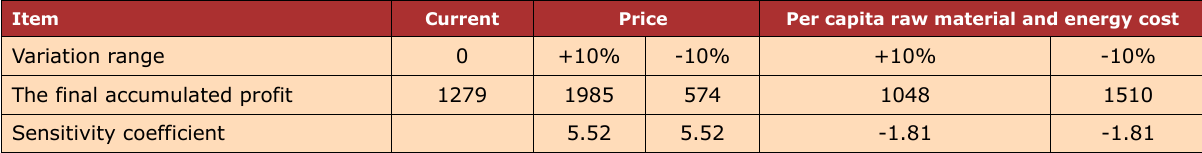
Table 1. Result of sensitivity